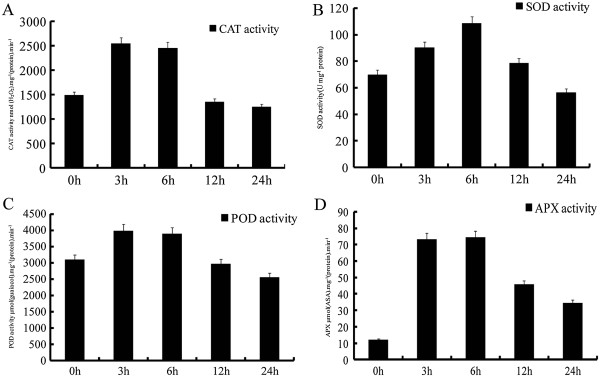
Change of SOD, POD CAT and APX activities response to heat stress. A: SOD activities; B: POD activities; C: CAT activities; D: APX activities. Activities are presented as means ± standard error, and n = 3.